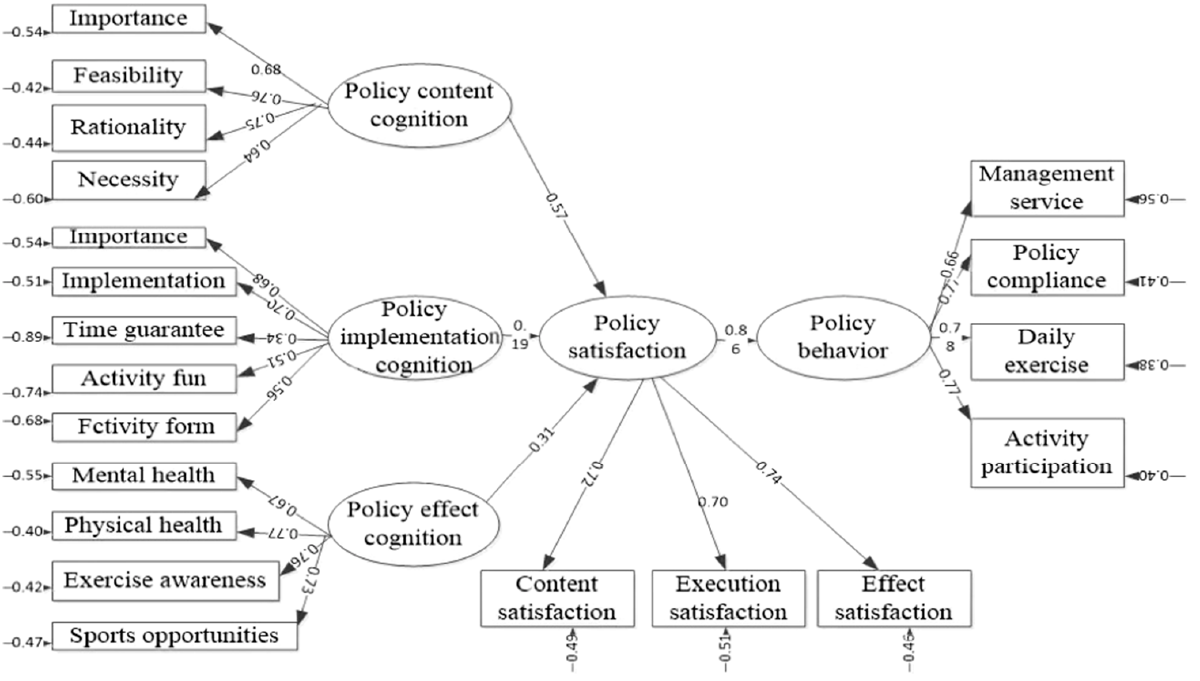
Figure 4. Structural equation model of school sports policy attitude